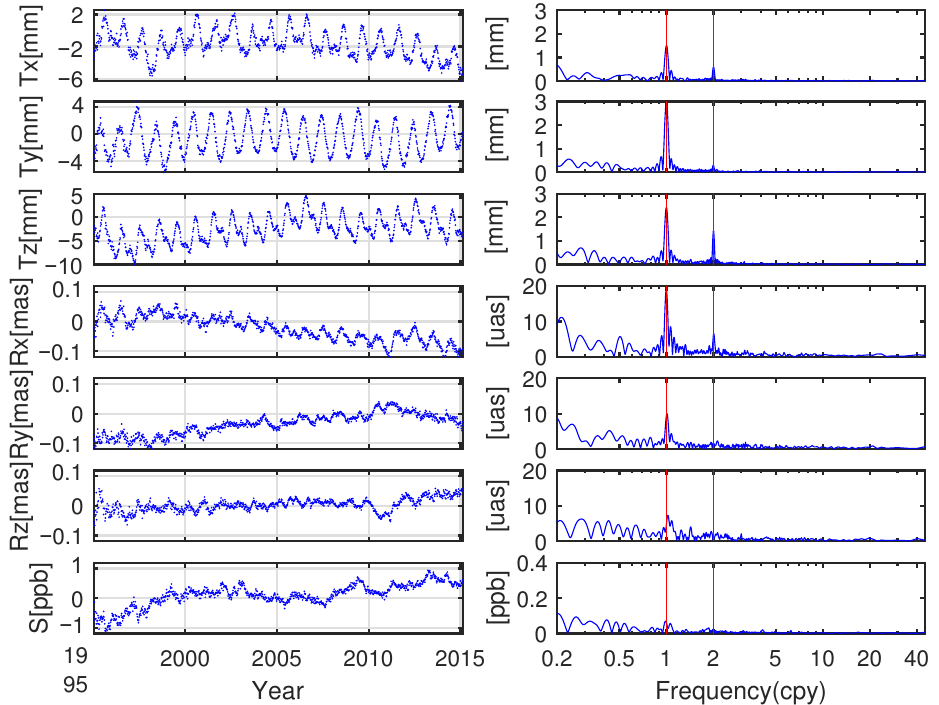
Figure 9. Time series of the translation, rotation, and scale offsets estimated between JTRF2014 and IGS and their amplitude spectra from top to